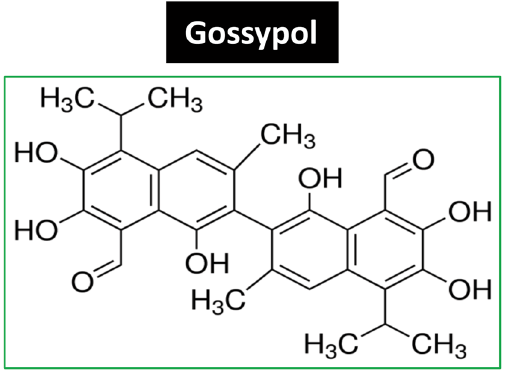
Figure 1. Chemical structure of gossypol (molar mass: 518.56 g/mol) (Image was from public domain